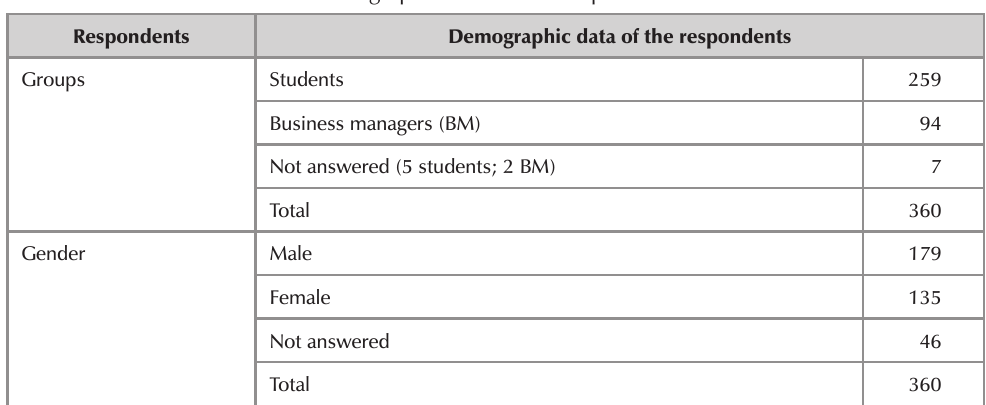
Demographic data of the